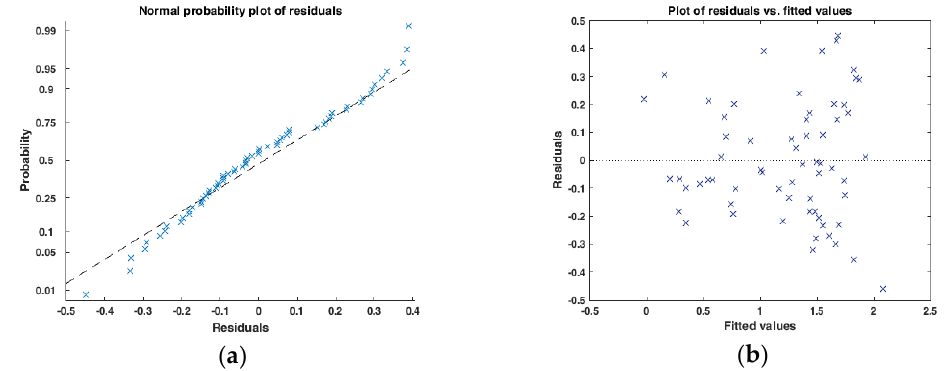
Figure 4. Normal distribution of the residuals without variables. ( a ) Normal probability plot of residuals ( b ) Plot of residuals vs. fitted values.